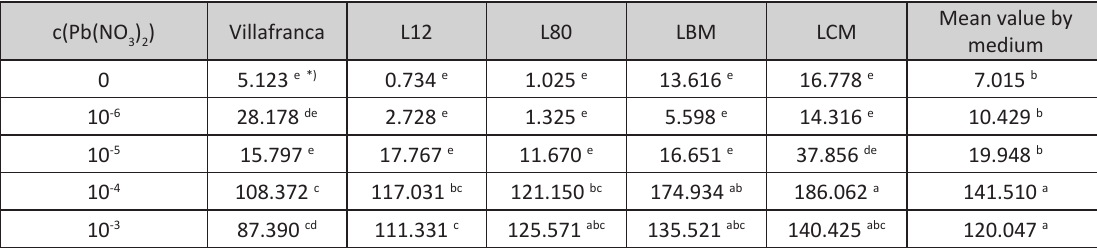
The lead content in dry shoot biomass (mg/kg) (shoot lead accumulation) in white poplar rooted shoots grown on examined growing media (LSD